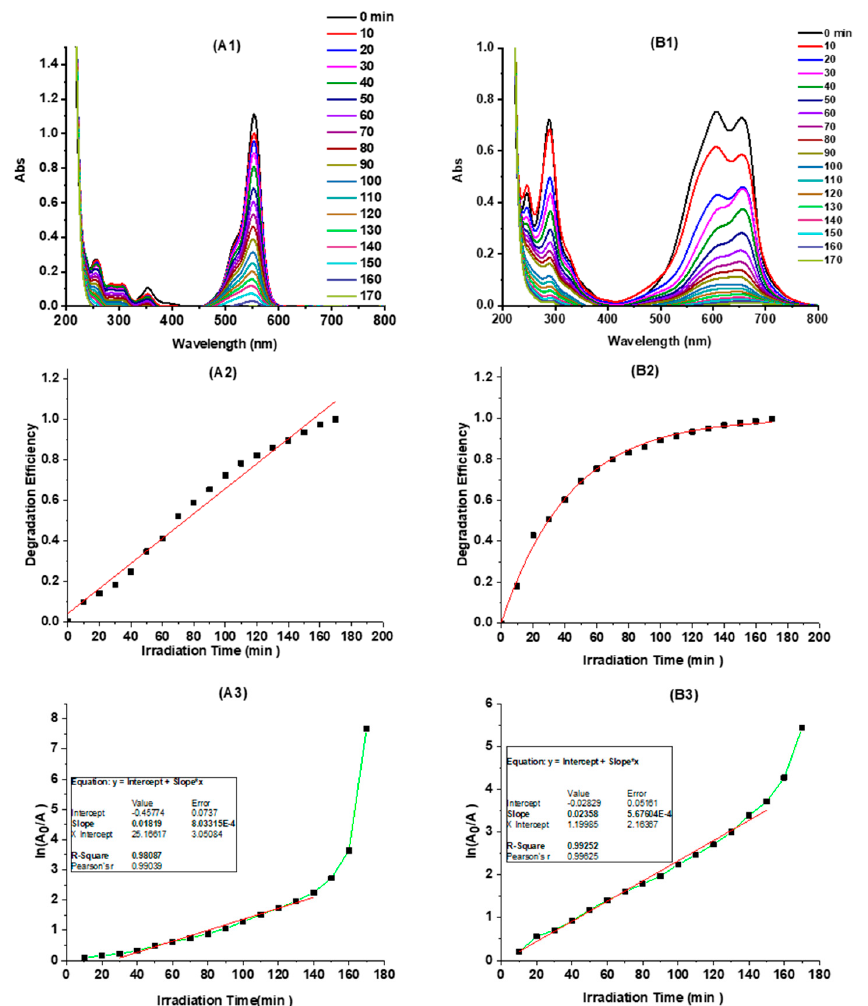
Figure 4. The photocatalytic degradation of rhodamine B (RhB) and methylene blue (MB) catalyzed by C-dots (0.75 mg/mL): the UV-Vis absorption spectra of RhB ( A1 ) and MB ( B1 ) at different irradiation times; the degradation efficiency (%) of RhB ( A2 ) and MB ( B2 ) by monitoring the absorption changes at 554 nm and 605 nm, respectively, at different irradiation times; irradiation-time-dependent pseudo first-order kinetics plots (ln( A 0 / A ) vs. irradiation time) of RhB ( A3 ) and MB ( B3 ).